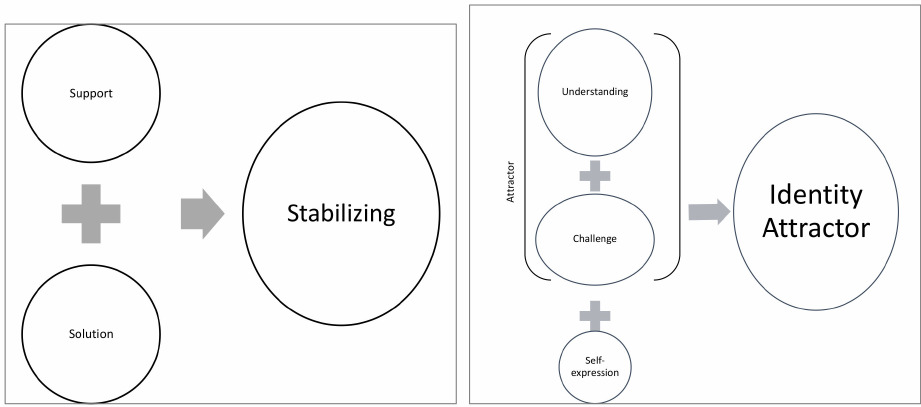
Figure 2. The interpretative factors: Creativity as a stabilizing factor and as an identity